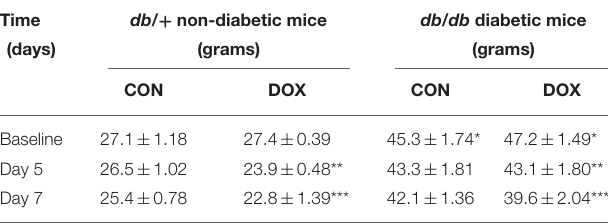
corresponding baseline (indicating the weight loss following DOX treatment on